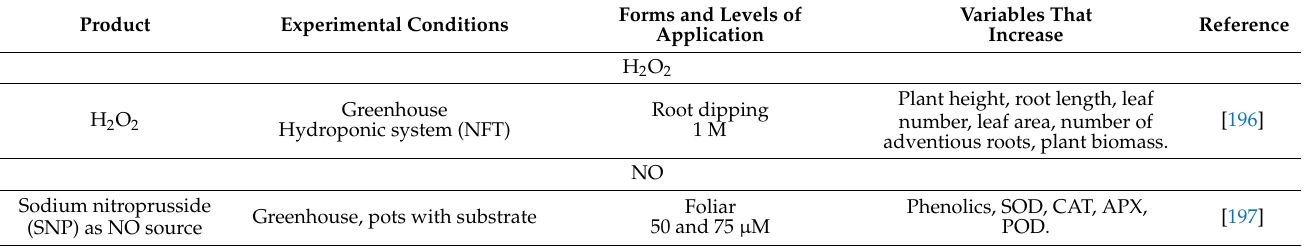
Table 8. Favorable effects of H 2 O 2 and gasotransmitters on some growth or quality variables of strawberry